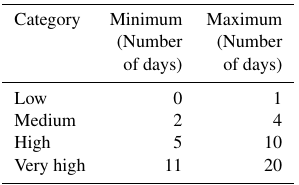
Table B2. Categories of flood duration for the French flood damage functions.